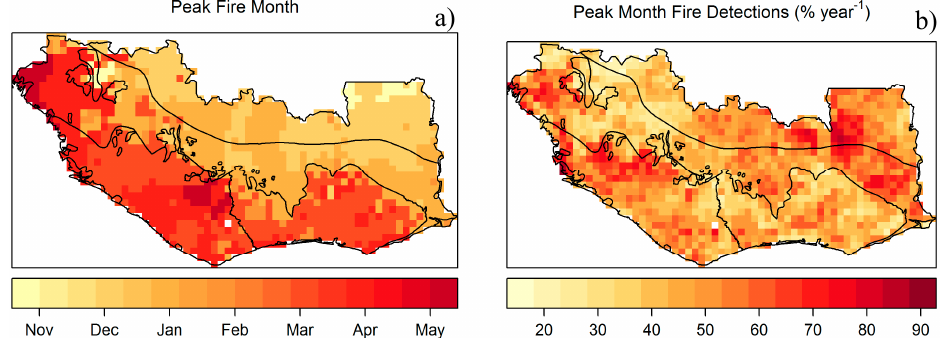
Figure 5. Maps indicating: ( a ) calendar month with the maximum active fire detections; ( b ) the percentage of the total annual active fire detections recorded in the peak fire month.